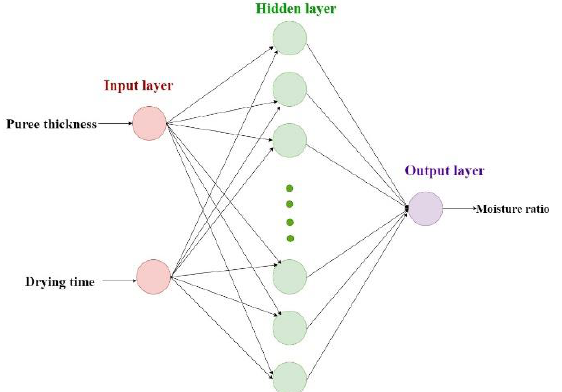
Figure 2. Diagrammatic representation of the ANN model.